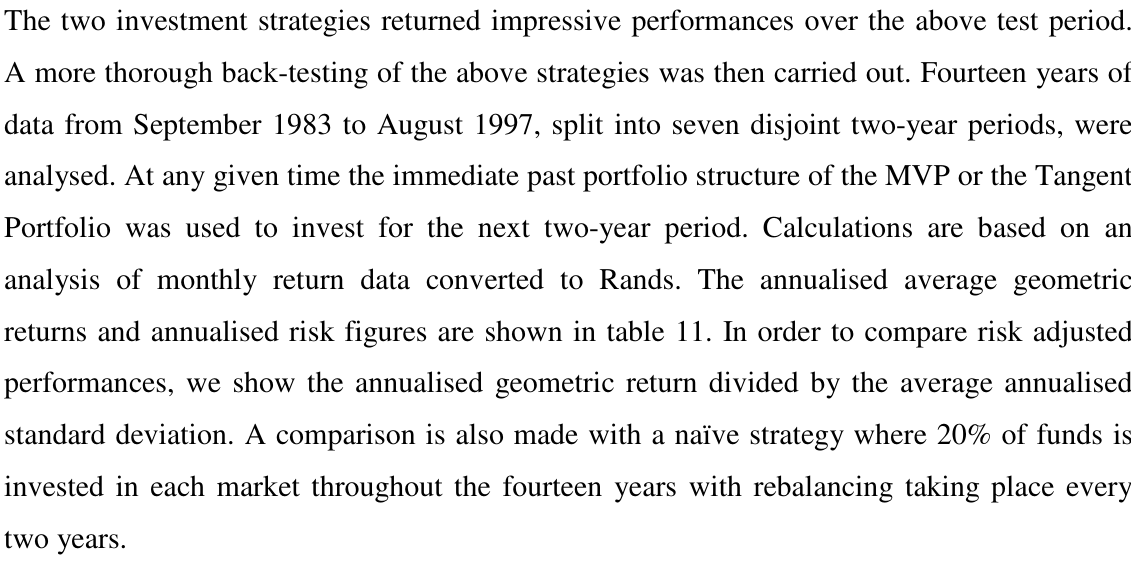
Table 10. Single period performance based on previous portfolio configurations The two investment strategies returned impressive performances over the above test